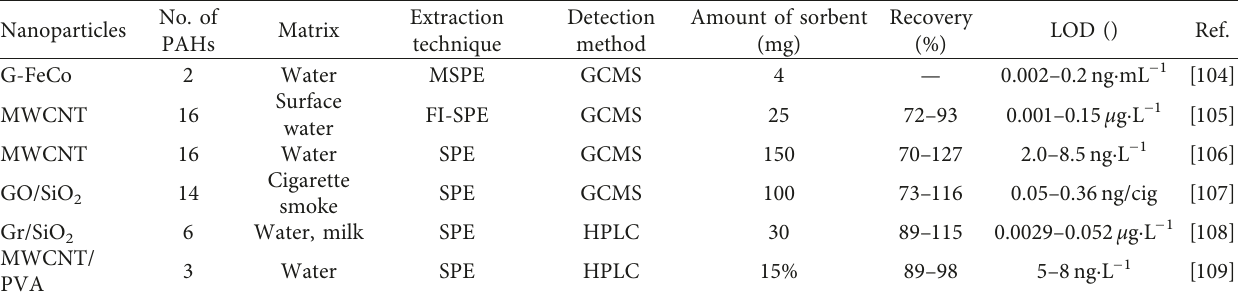
Table 10: Some CNPs used in the extraction of